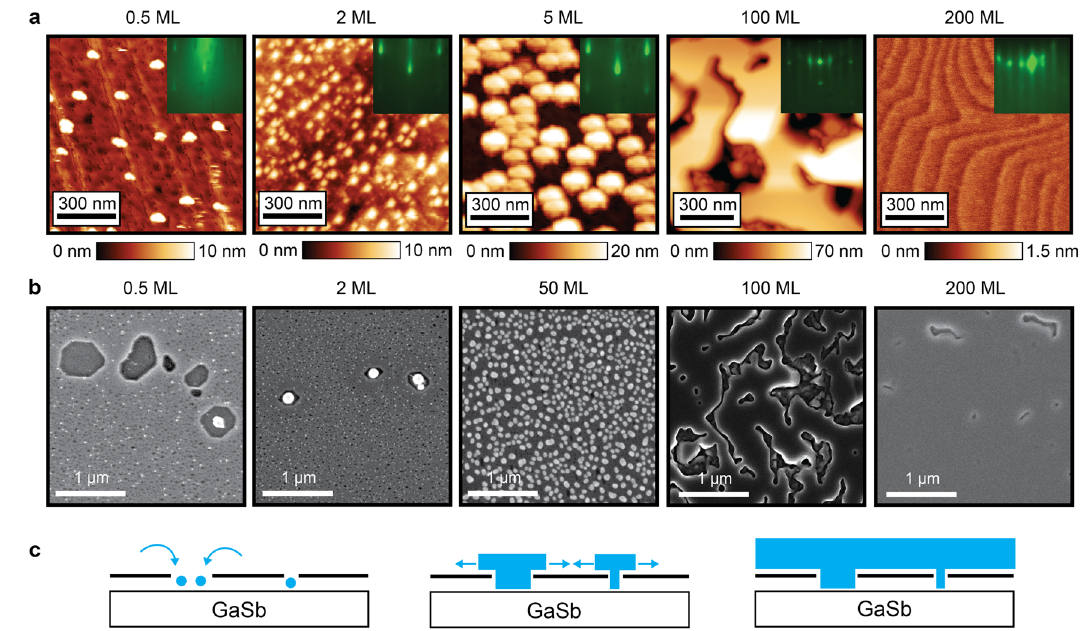
Fig. 4 Seeded lateral epitaxy at the graphene pinholes. a AFM images tracking the evolution of GaSb nucleation at pinholes in the graphene (<2 monolayers, ML), followed by lateral overgrowth (5 ML) and coalescence into an atomically stepped continuous fi lm (200 ML). One monolayer is de fi ned as half the thickness of a unit cell a /2 = 3 Angstrom, corresponding to an areal density of 5.4 × 10 14 atoms/cm 2 each of Ga and Sb. The GaSb growth temperature was 500 ∘ C and the oxide desorption temperatures were 520 − 540 ∘ C. Inserts show RHEED patterns at each stage of growth. b SEM images showing the nucleation at both small and large holes. The islands extend and coalesce around 50 – 100 ML, and nearly full coalescence is observed after 200 ML fi lm growth. c Schematic of lateral epitaxy seeded at holes in the graphene. Blue circles represent GaSb